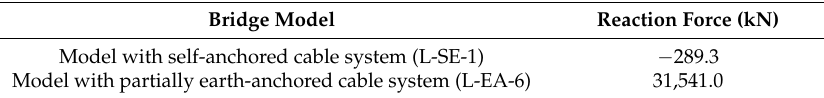
Table 4. Longitudinal restraint reactions before the set back process.